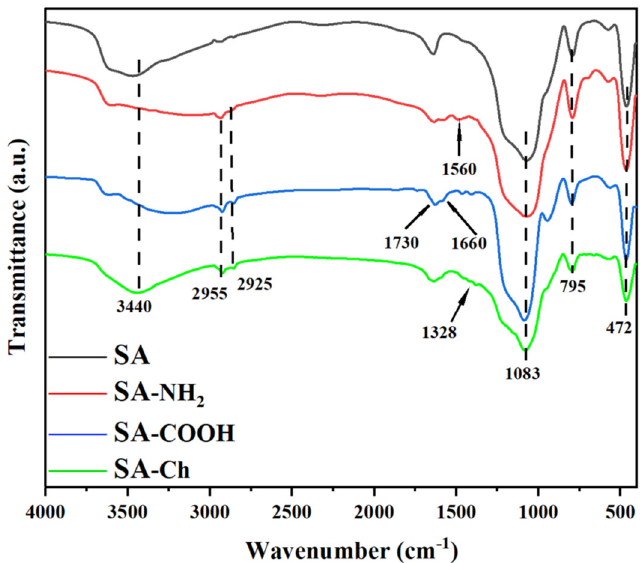
Figure 3. FT−IR patterns of the original and modified SAs. Figure 3. FT − IR patterns of the original and modified